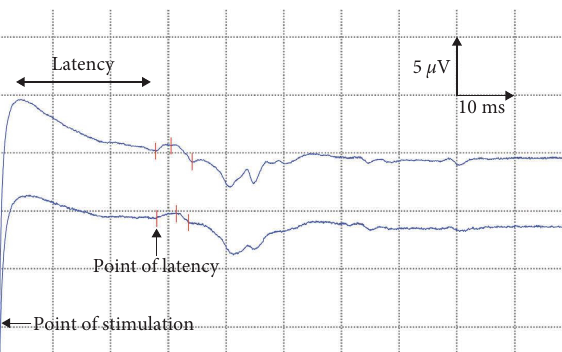
Figure 6: An example of electrophysiological bulbocavernosus refex (EBCR) in a healthy spayed female dog. Two traces were obtained from the same subject to ensure the reproducibility of the response.